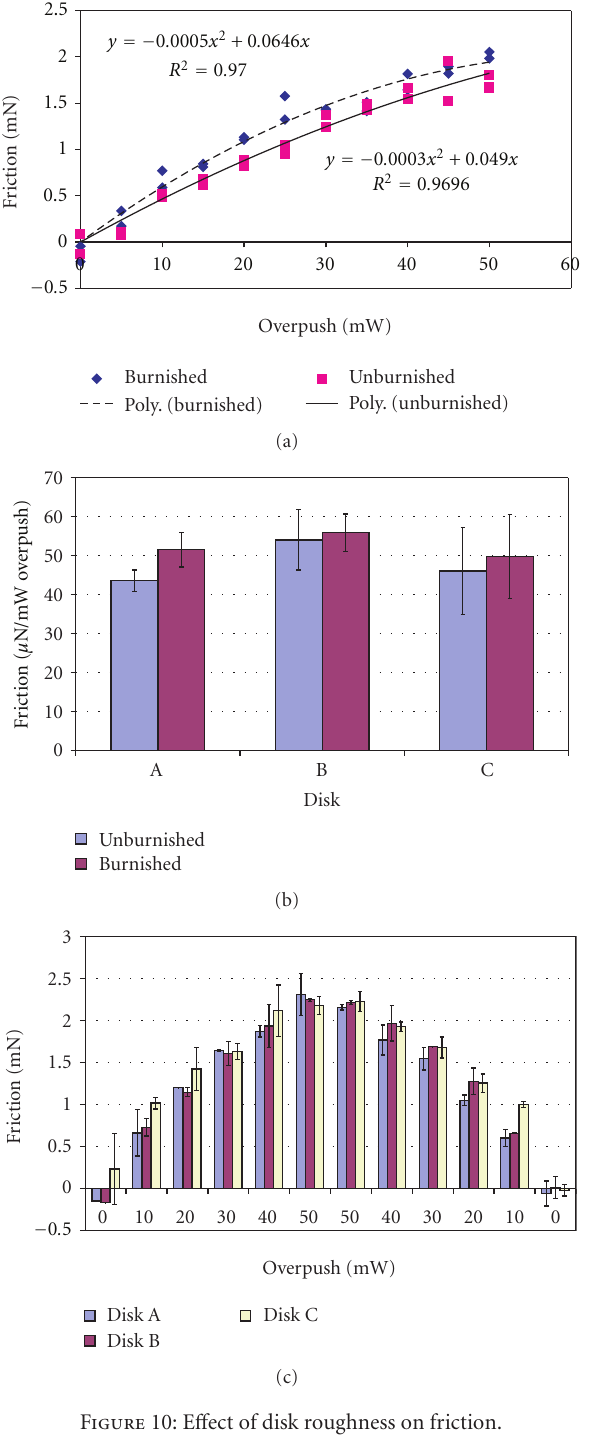
Figure 10: E ff ect of disk roughness on friction.